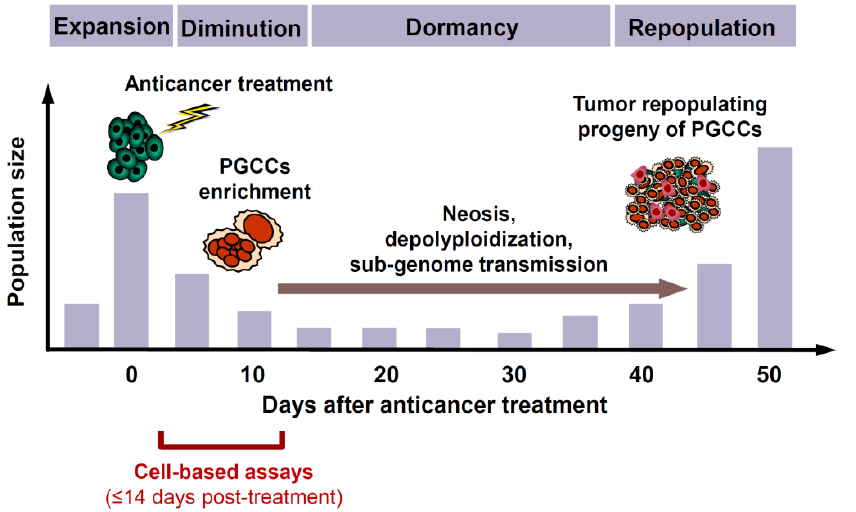
Figure 1. Cartoon illustrating the role of polyploid/multinucleated giant cancer cells (PGCCs) in tumor response to anticancer agents. Although anticancer treatment results in initial tumor shrinkage and a dormant state several weeks post-treatment (e.g., ~35 days in a rat colon carcinoma model [67]), it also triggers the creation of PGCCs that give rise to therapy resistant and tumor repopulating progeny through neosis (nuclear budding and bursting), depolyploidization involving meiosis and self-renewal genes, and sub-genome transmission (transfer of nuclear material into surrounding cells via cytoplasmic tunnels). For further details, please consult [50].